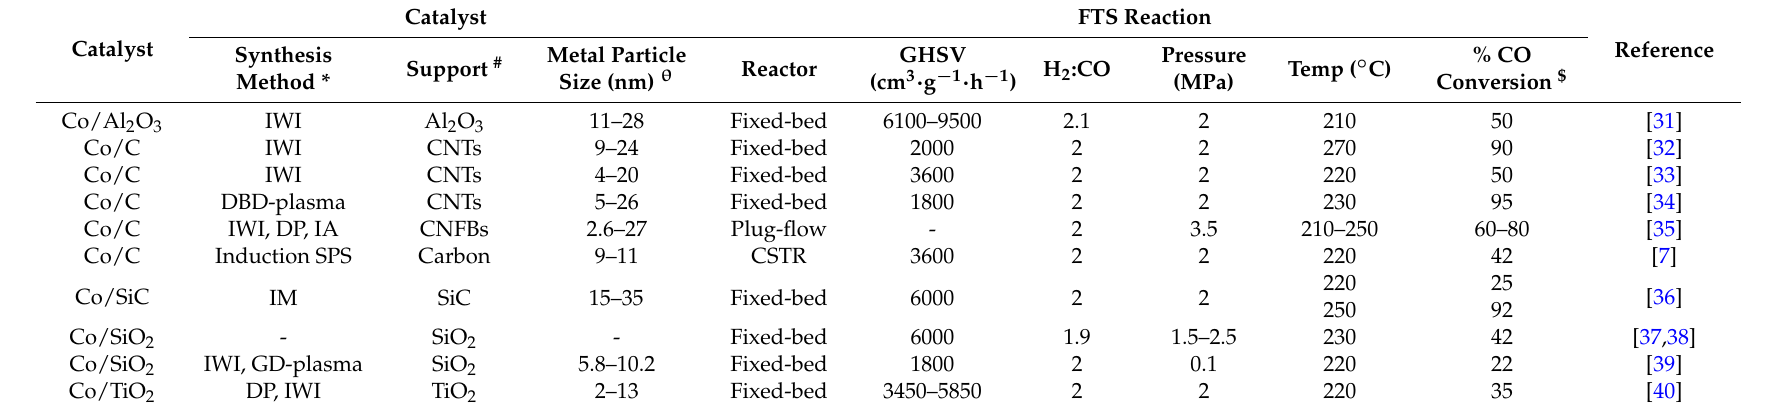
Table 1. Some Co catalysts that have been tested in typical FTS reaction